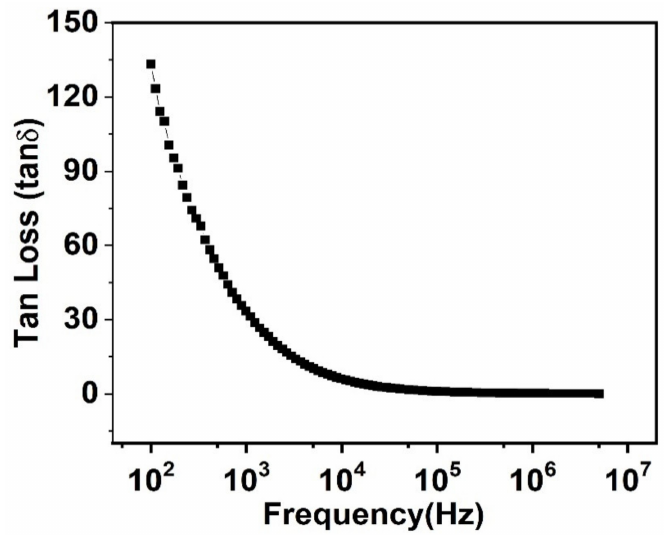
Figure 7. Change of tangent loss of prepared PbSe along with the change of